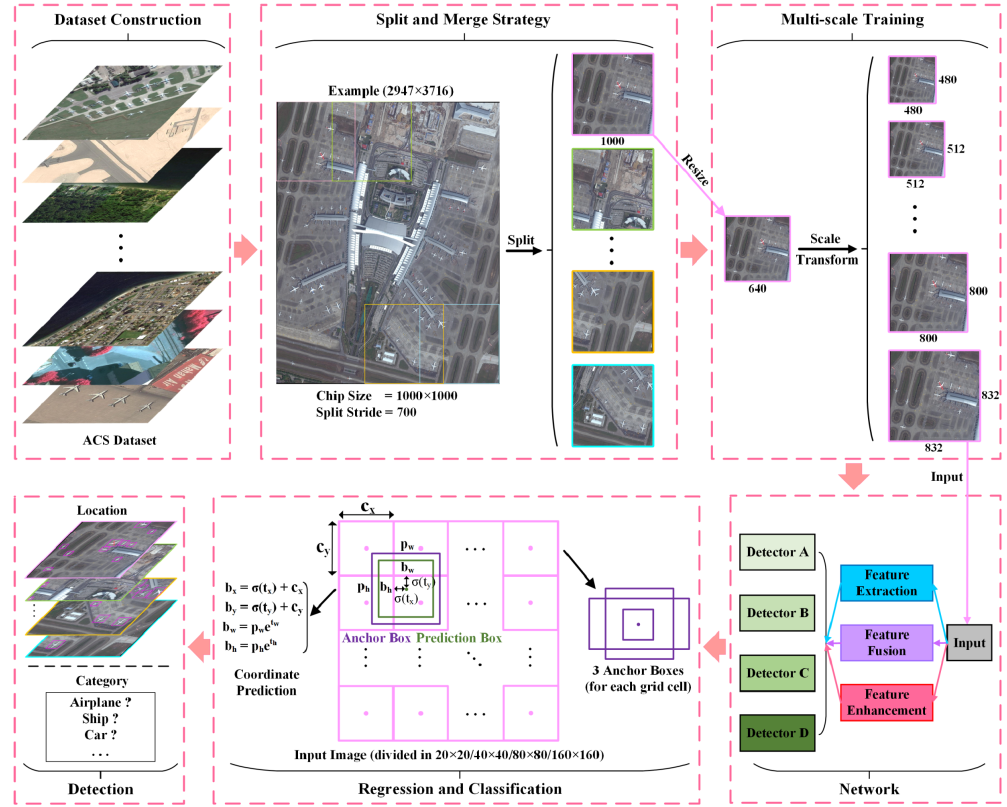
Figure 2. Detection process. The detection process can be divided into six parts. Specifically, the dataset construction will be described in detail in Section 3.1.1, the split and merge strategy in Section 3.3.1, the multi-scale training in Section 3.3.2, the network architecture in Section 2.2, and the regression and classification in Section